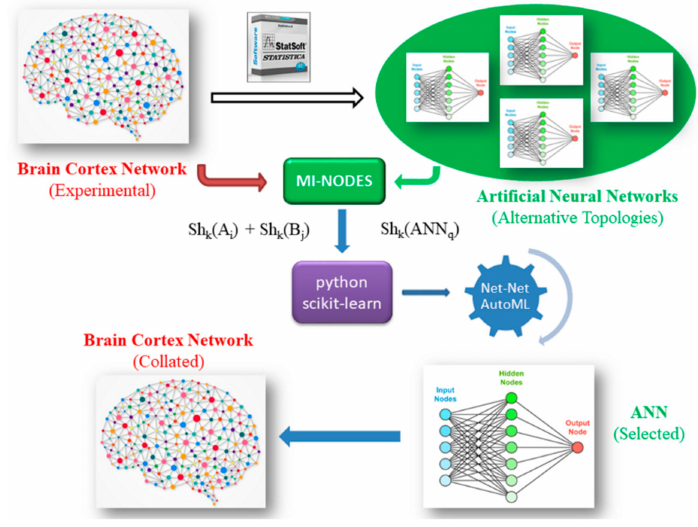
Figure 1. Proposed